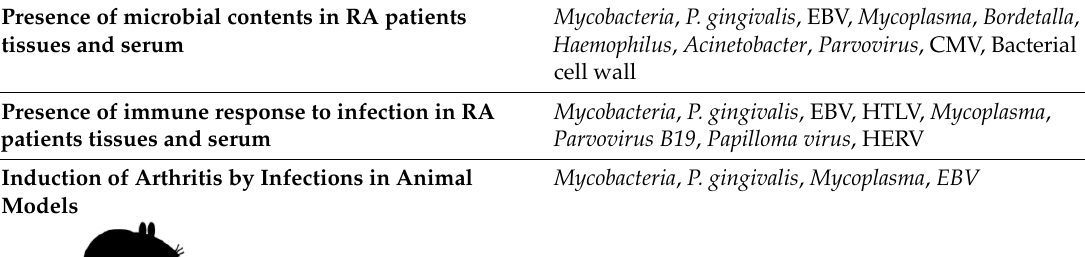
Table 1. In vivo and in vitro studies of microorganisms related to RA.